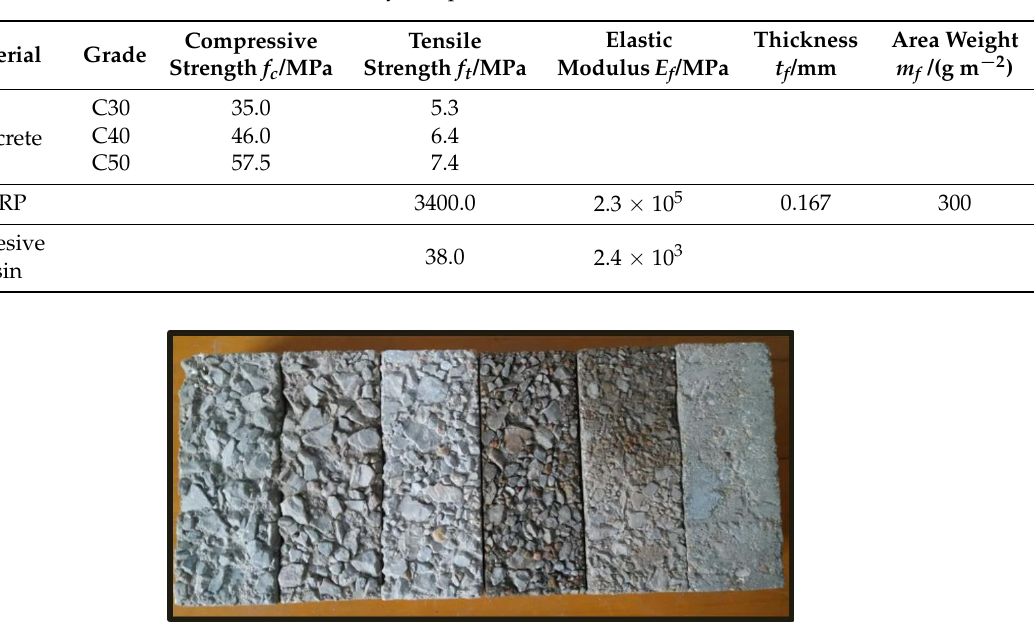
Figure 1. Concrete surfaces with different roughness.